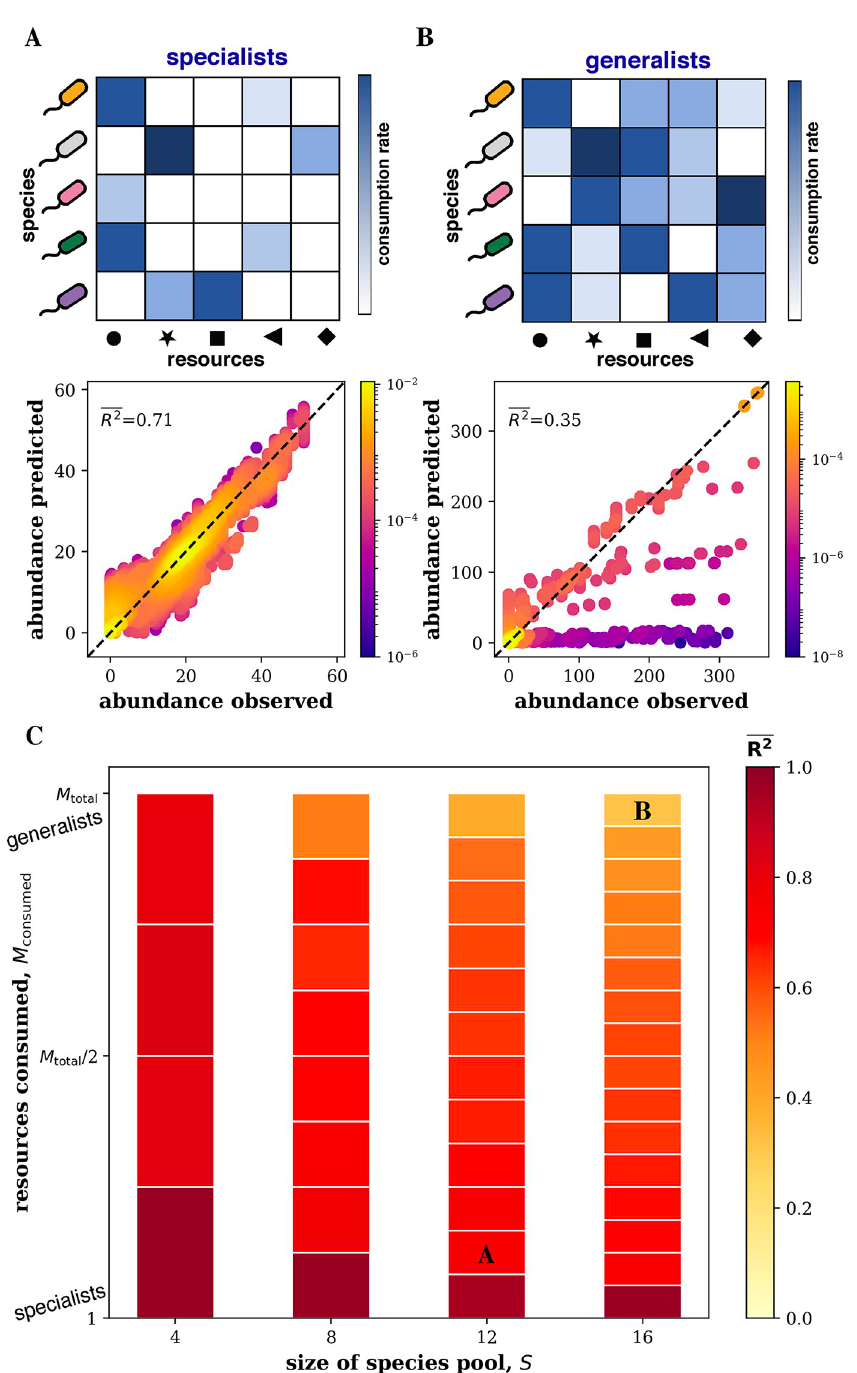
Fig 2. Niche overlap determines the linearity of ecological landscapes. The top panels in (A) and (B) show the consumption matrices for species in each species pool. In (A), the niche overlap is low because the species are specialists and consume only a few resources. In (B), the niche overlap is high because the species are generalists and consume many resources. The bottom panels show how well a linear model (Eq 1) fits the steady-state abundances across all possible species combinations. Color bar quantifies the local density of points, as measured by gaussian kernel density estimation. The goodness of the model fit, quantified by R 2 , is higher when the niche overlap is lower. This conclusion is robust to varying the size of the community and the degree of niche overlap. (C) shows how R 2 varies with the number of species in the pool, S , and the average number of resources that they consume, M consumed . The degree of niche overlap is determined by M consumed / M total . Letters indicate the parameters used in panels A and